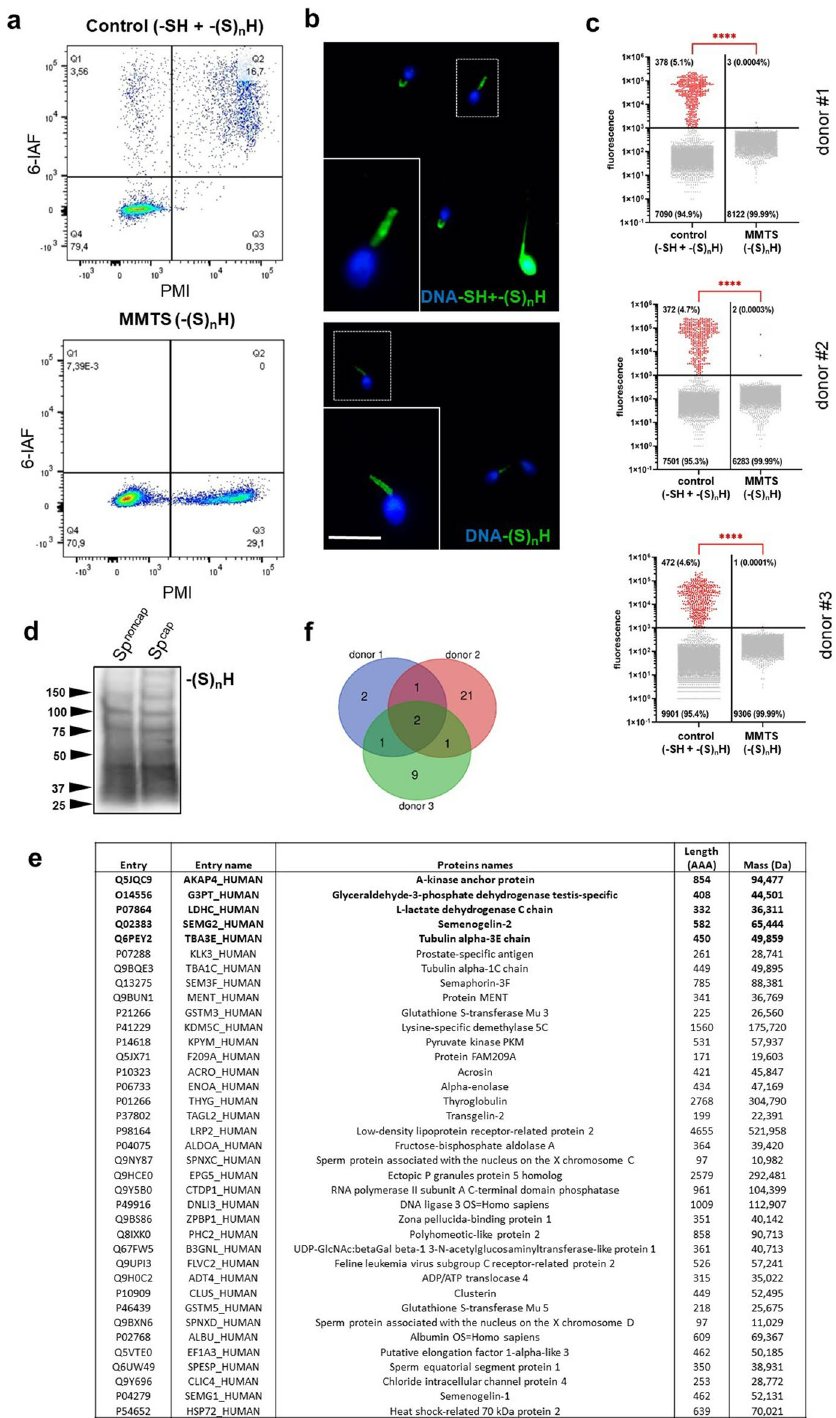
Figure 6. Free thiols and persulfidation analysis of proteins in human spermatozoa. ( a ) Flow cytometry of thiols (–SH) and persulfidation (–(S) n H) in spermatozoa due to 6-iodoacetamidofluorescein (6-IAF) staining without (control) and with (MMTS) blocking of free thiols. The dot plot shows the separation of sperm subpopulations according to plasma membrane integrity (PMI) and 6-IAF signal intensity. ( b ) Representative images of –SH and –(S) n H detection in situ showing 6-IAF staining patterns in the MMTS and control groups. The white rectangle indicates the –(S) n H-assumed signal in the midpiece of emphasized spermatozoa (scale bar: 10 μm). Spermatozoa were emphasized (1000×). ( c ) Presence of –SH + –(S) n H in the control and –(S) n H in the MMTS groups in live spermatozoa of three donors. Differences between the fluorescent signals belonging to –SH + –(S) n H and –(S) n H. Dots represent the fluorescence signal of individual spermatozoa. Lines express the mean of measured spermatozoa tested on live sperm subpopulations using the one-sample Wilcoxon test (****, P < 0.0001). ( d ) Persulfidated proteins separated by molecular weight in human spermatozoa being noncapacitated (Sp non-cap. ) or capacitated (Sp cap ). ( e ) All detected persulfidated proteins are shown in the table. Persulfidated proteins that matched at least in two donors are shown in bold. ( f ) Venn diagram shows 37 persulfidated proteins identified in three independent donors by